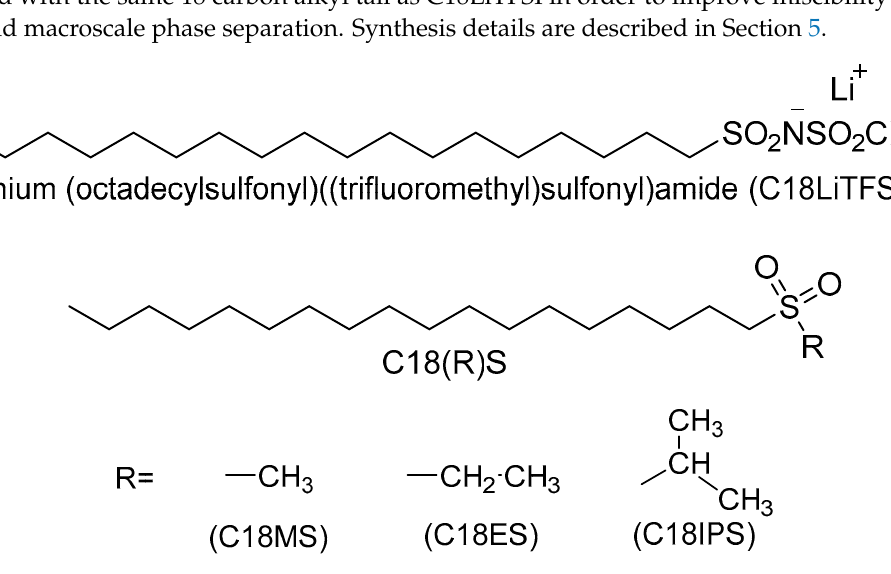
Figure 1. Molecular structures of C18LiTFSI and additive sulfonyl molecules.